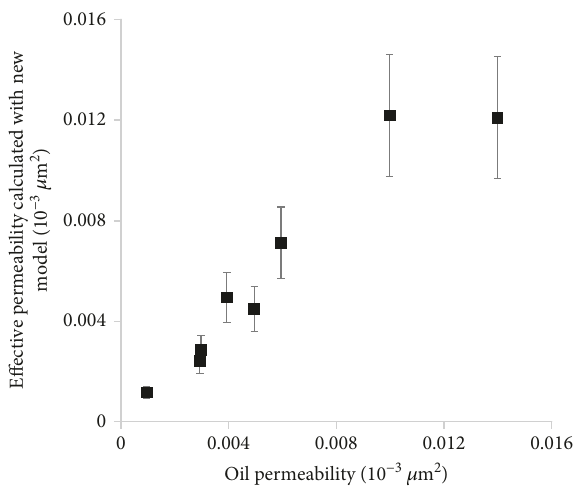
Figure 9: Comparison between experimental data and calculated data from the